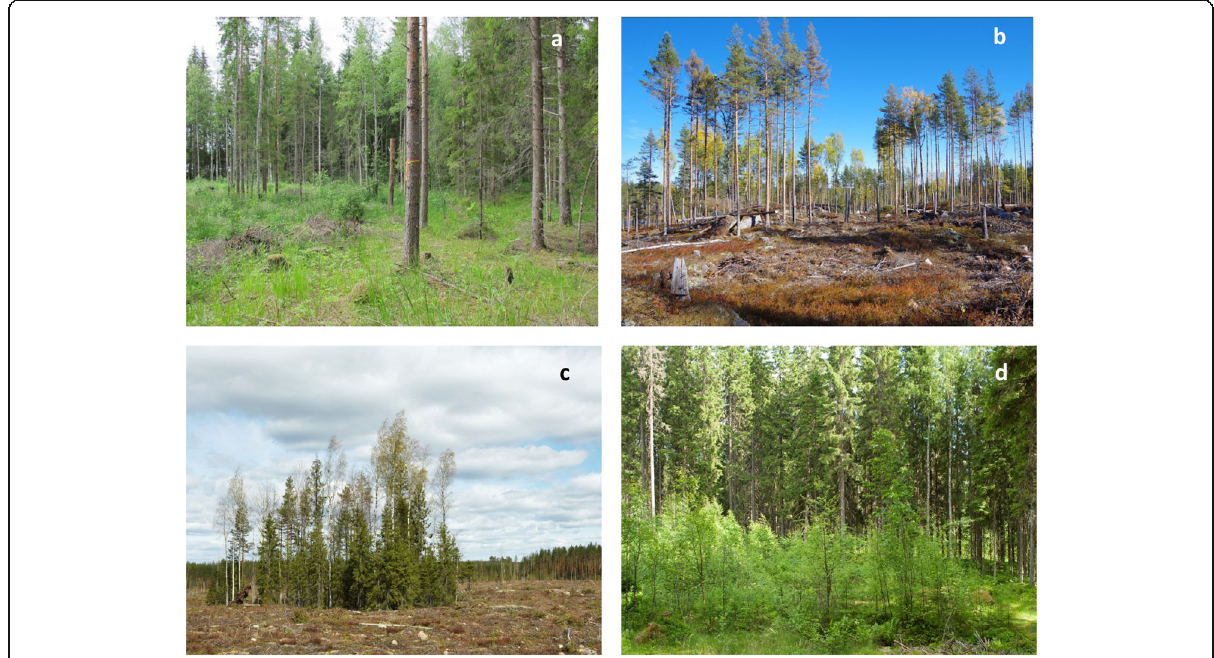
Fig. 3 Examples of retention experiments in Finland and Sweden. a Gap felling with 5% group retention inside a gap, spruce forest, third post- harvest summer. DISTDYN project in Finland. Photo: Matti Koivula. b In the Swedish experiment, Effaråsen, Scots pine stands have been harvested with retention levels varying from 3 to 100%. At each level the retention included equal proportions of intact green trees, girdled trees, high-cut trees, and felled trees. In the picture, a level of 30% retention is shown. Photo Line Djupström. c Retention tree group inside a clear-felled area. In the RETREE project, varying sized retention tree groups, 0.1-0.6 ha were left in a harvested area. Photo: Erkki Oksanen/LUKE. d . Naturally regenerated gap in the MONTA experiment 14 years after harvesting. Photo: Erkki Oksanen/LUKE. For more information on the experiments, see Table 2, and for their location, see Fig.